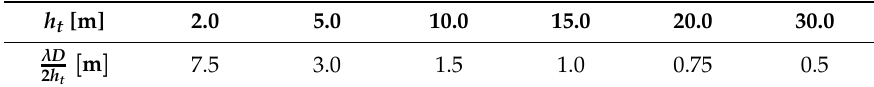
Table A2. Period of η 4 for λ = 0.03 m and D = 1000